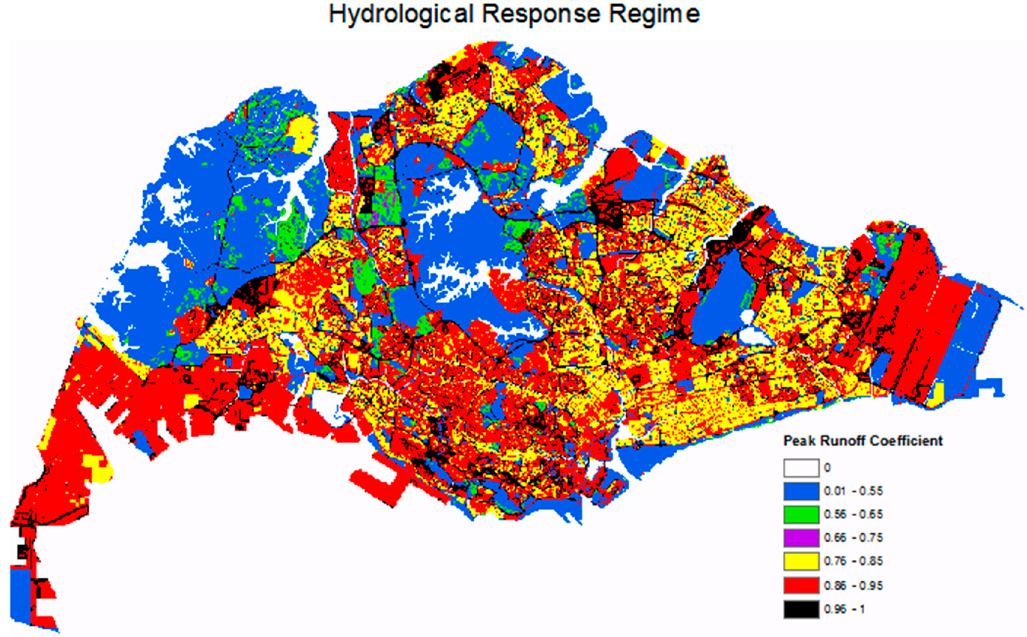
Figure 9. Hydrological response regime of Singapore (Peak C values) for current land use without any ABC Waters design features.